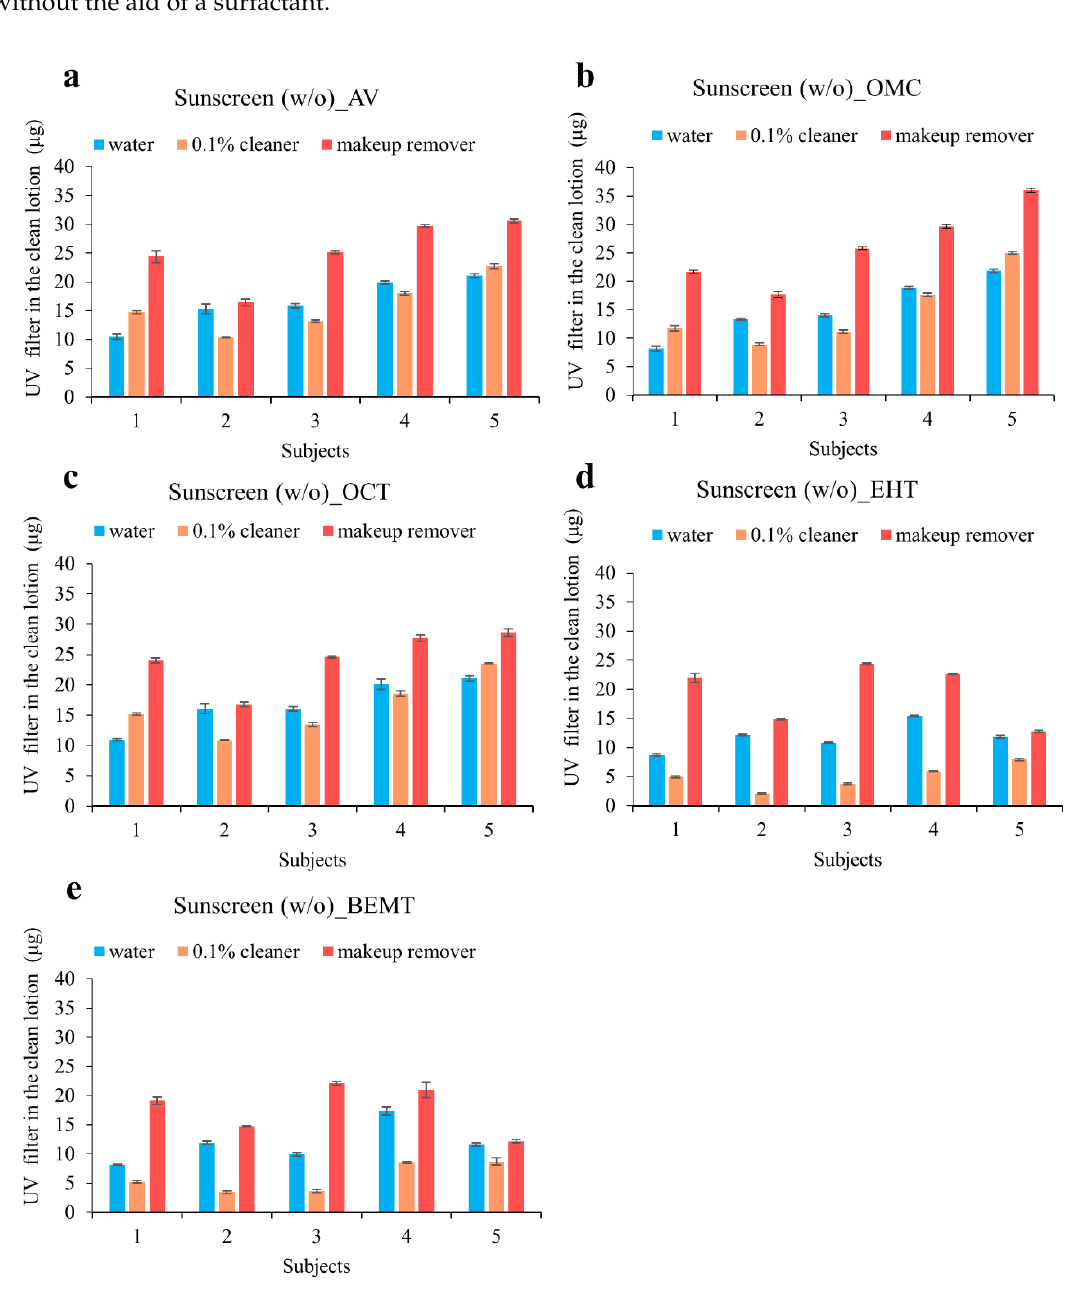
Figure 4. Effects of three cleaning solutions (water, 0.1% facial cleanser, and makeup remover) on the removal of the UV filters of home-made sunscreen (w/o) on the skin of five human volunteers.